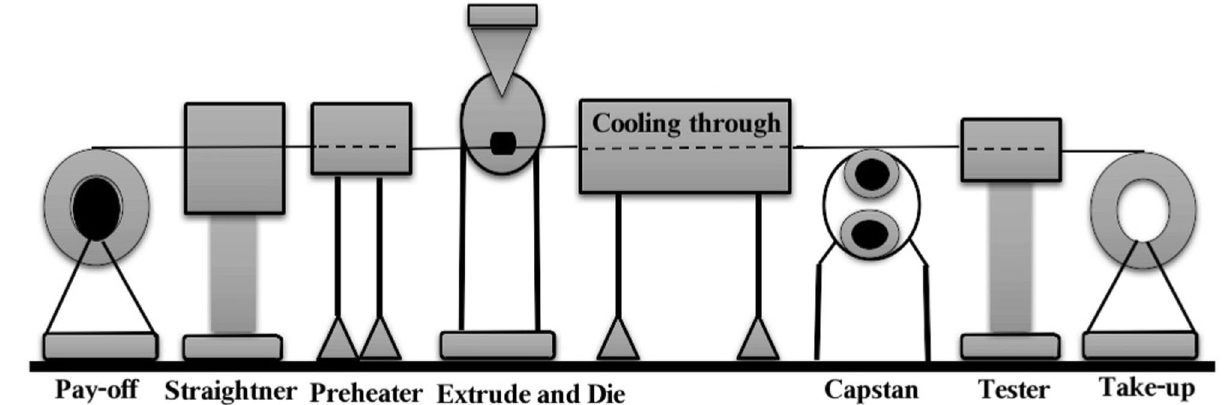
Figure 1. WCS-EPF for wire processing.